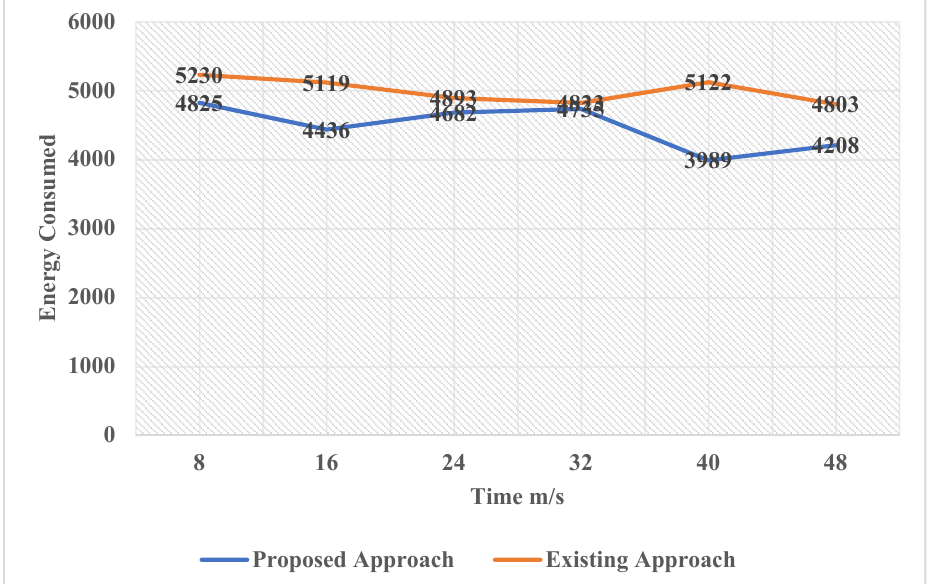
Figure 10. Energy Consumed by each Node as a Function of Time.